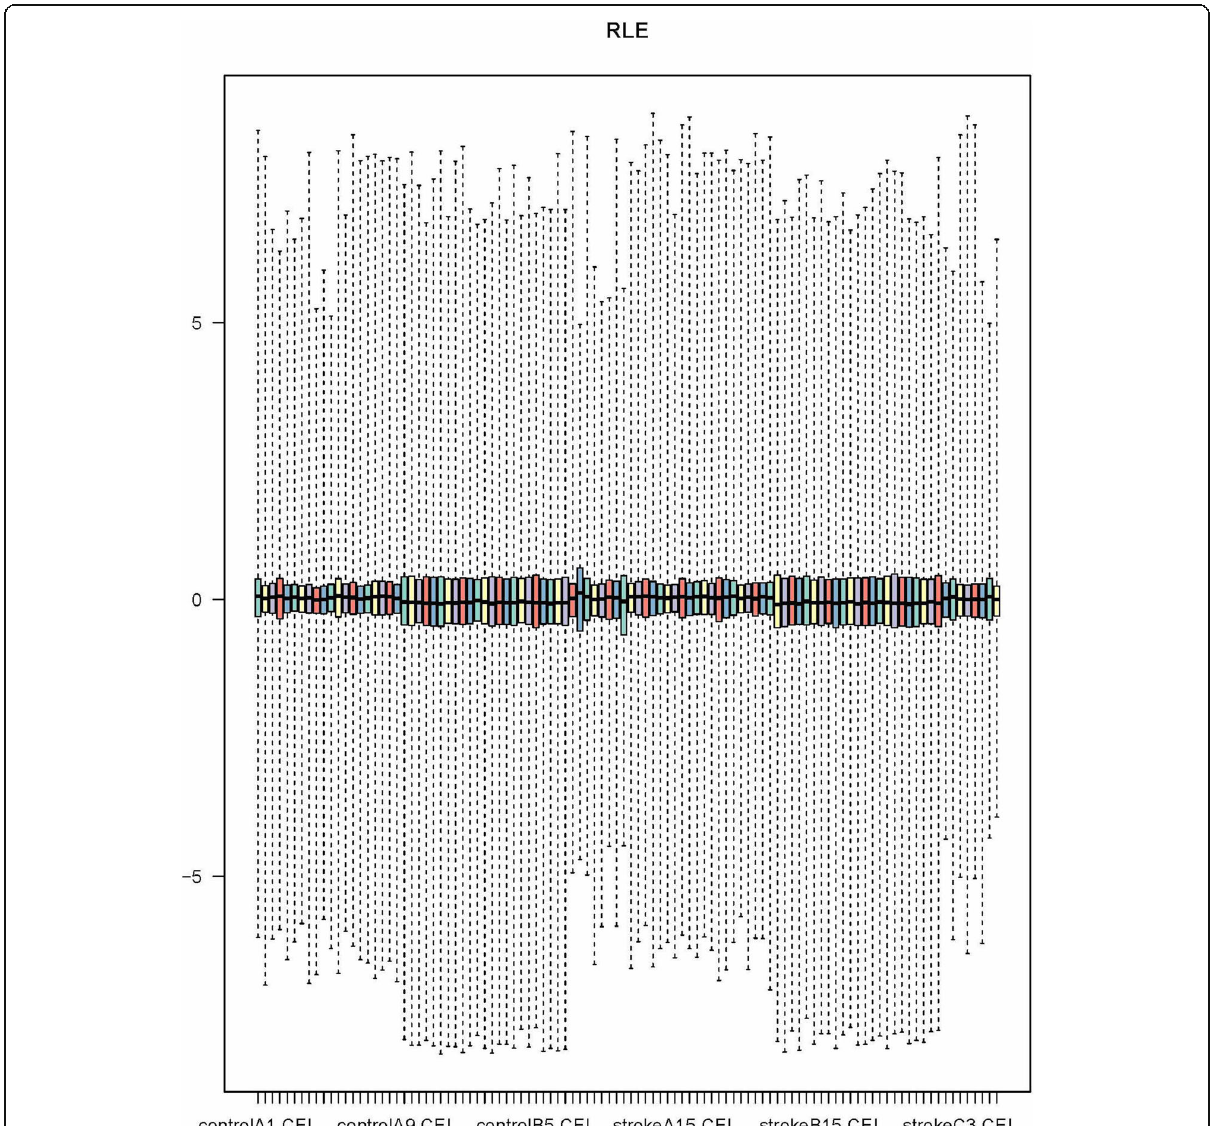
Fig. 2 Relative Log Expression (RLE) signal graph